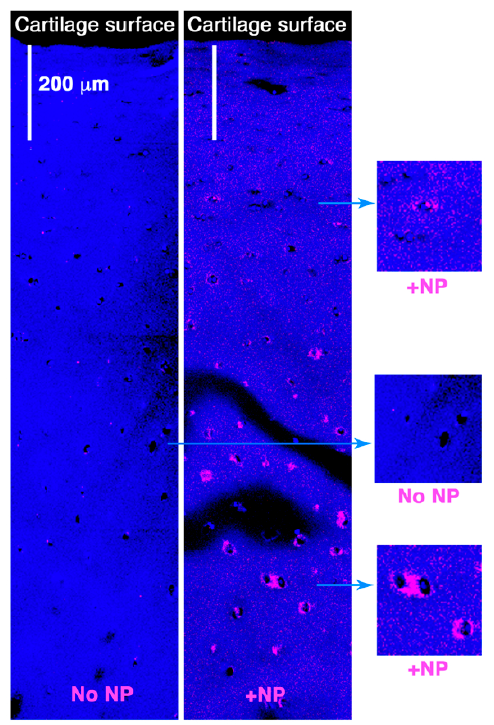
Figure 1. Cy3-labeled p5RHH naked nanoparticle (NP) or hyaluronic acid-coated p5RHH NP (HA-NP) were incubated with bone-marrow-derived macrophages (BMM ϕ ) for 4 h then analyzed by confocal microscopy ( A ). NP = red; F-actin = green; scale bar = 25 µm. HA-coating enhanced cellular interaction and uptake (higher magnification: far right panel). ( B ) Flow cytometric analysis of BMM ϕ after 4 h of incubation with NPs. Values represent mean ± SEM, n = 3, * p < 0.05.